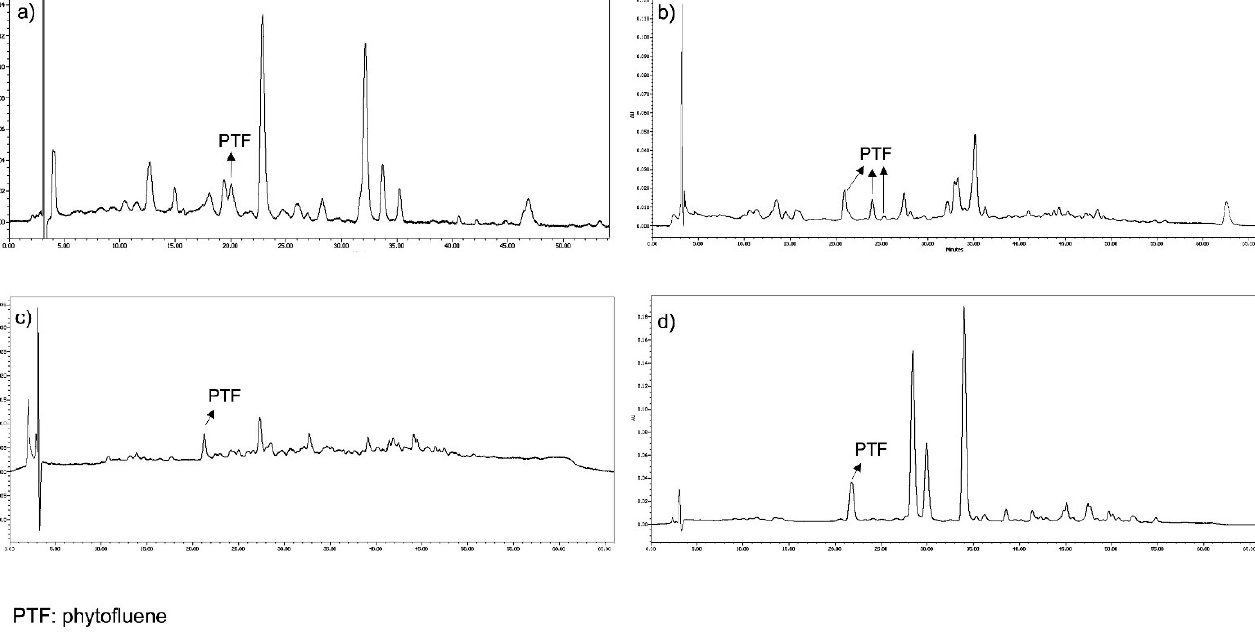
Figure 3. Chromatogram at 370 nm of a sample of serum ( a ), faeces ( b ), orange ( c ) and pumpkin ( d ).